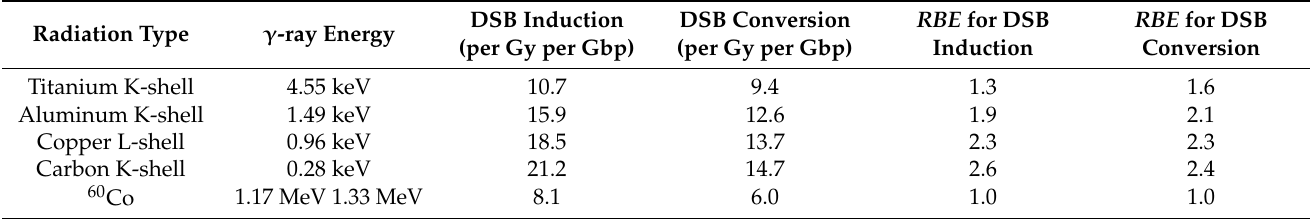
Table 6. The relative biological effectiveness ( RBE ) of double-strand break (DSB) induction and enzymatic DSBs for long-patch base excision repair (LP BER) for cells irradiated with ultrasoft X-rays or 60 Co γ -rays. Radiation Type γ -ray Energy Titanium K-shell Aluminum K-shell Copper L-shell Carbon